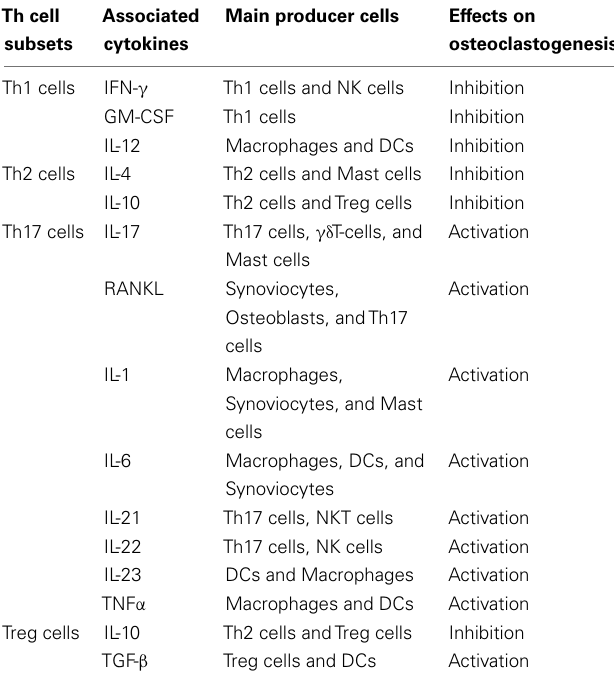
Table 2 |T-cell-related cytokines and